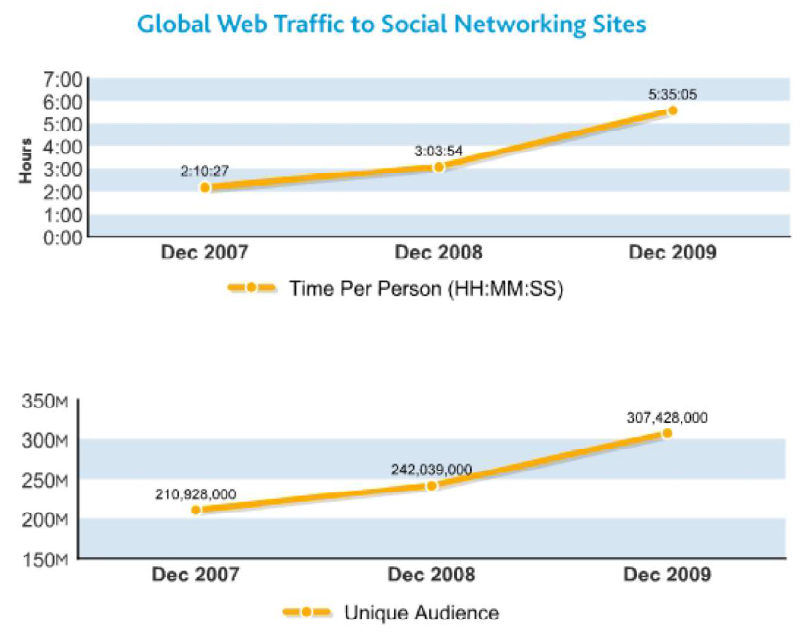
Figure 1: Recent trends in Social Networking worldwide (Nielsenwire 2010) Looking at the bottom diagram first, with 307.4 million unique visitors (about two thirds of which are actually seen on Facebook), overall traffic exhibits a 46% increase in two years. In the same period, as the top graph displays, the average user is spending more time per month on social networks and blogs - five and a half hours at the end of 2009, with a 158% progress over 2007. In a similar vein, a previous analysis conducted at Morgan Stanley (2009) using 2008 data from the ComScore Digital World survey in the US, pointed at social networks as a “ fast growth – low penetration ” Internet category, or another example of Chris Anderson’s (2004) “ long tail ” markets, as documented by the following picture: